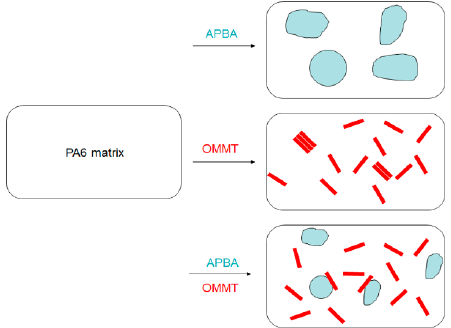
Scheme 2. The schematic illustrations for different PA6 composites.